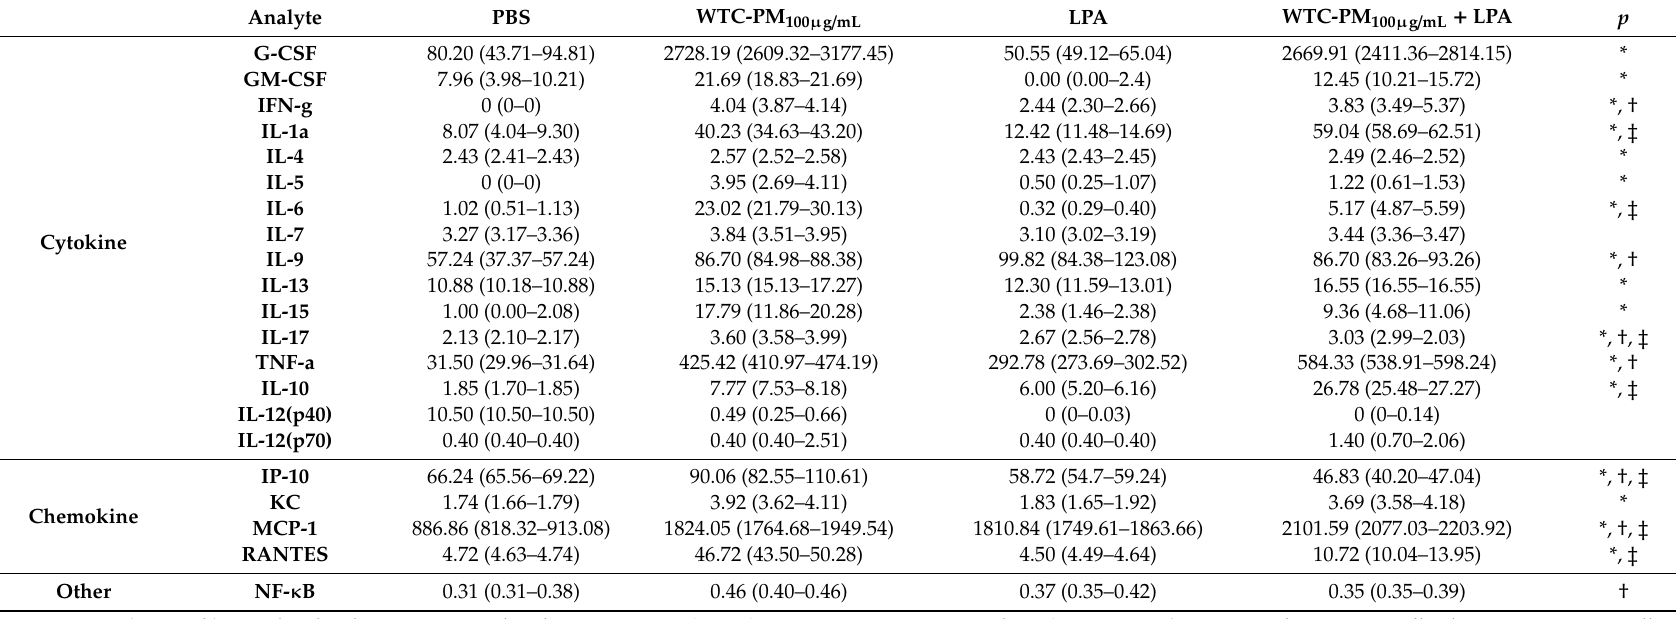
Table 2. Analyte Profile of RAW265.7